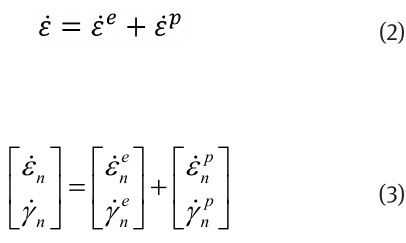
Figure 5: Scheme of the load of joint